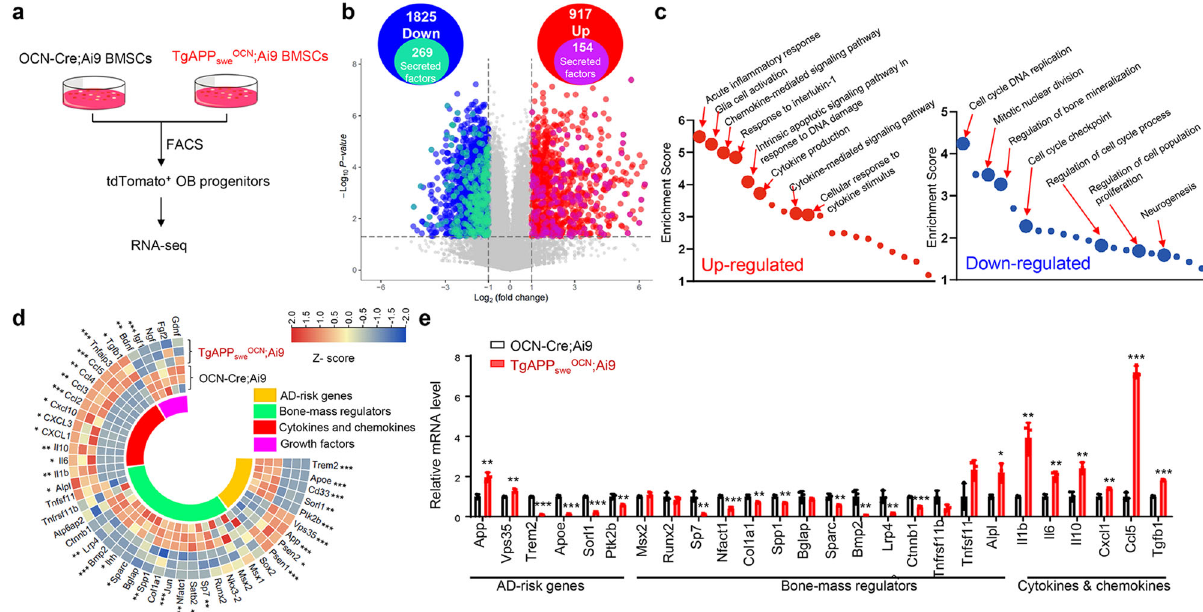
Fig. 5 Increased cytokines and chemokines in APP swe + OB-progenitor cells. a Schematic of puri fi cation and RNA-seq of Tdtomato + (Td + ) OB progenitors from control ( OCN-Cre; Ai9 ) and TgAPP swe OCN ; Ai9 mice. b – d Volcano plots ( b ), GO analysis of up/down-regulated genes ( c ), and heat map ( d ) of differentially expressed genes identi fi ed by RNA-seq. e RT-PCR analysis of AD risk gene App, Vps35, Trem2, Apoe, Ptk2b , and Sorl1 ; bone-mass regulator Sp7, Nfatc1, Col1a1, Spp1, Sparc, Bmp2, Lrp4 , and Ctnnb1 ; cytokine Il1b, Il6 , and Il10; chemokine Ccl5 and Cxcl1 , growth factor Tgfb1 gene expression in puri fi ed Td + OB progenitors from 6-MO control ( OCN-Cre; Ai9 ) and TgAPP swe OCN ; Ai9 mice. All values were presented as mean ± SD ( n = 3 mice). * p < 0.05, ** p < 0.01, and *** p < 0.001, by Mann – Whitney U test.